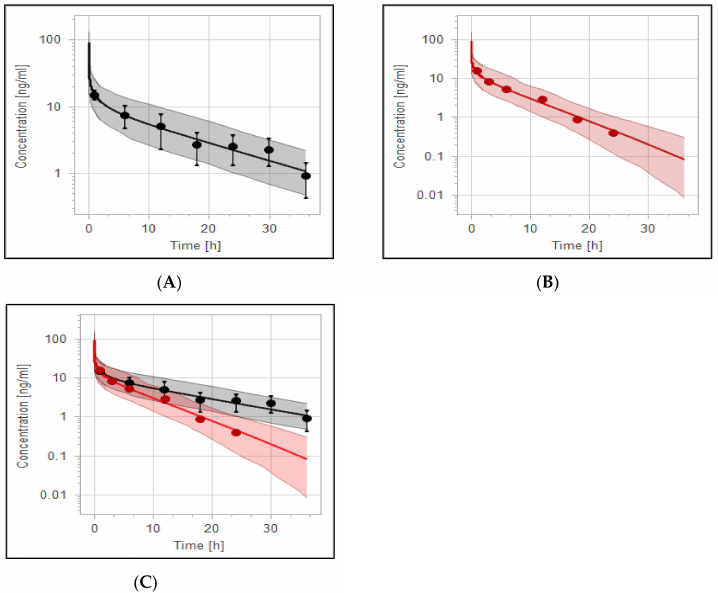
Figure 7. Effect of tuberculosis on PK of haloperidol with and without anti-TB rifampicin as a CYP3A4 inducer. ( A ) Haloperidol 5 mg IV in TB patients not treated with rifampicin. ( B ) Haloperidol 5 mg IV treated with rifampicin. ( C ) Simulation comparison for haloperidol with and without rifampicin. The red solid line represents the mean plasma concentration of haloperidol alone, while the black solid line represents the mean plasma concentration of haloperidol plus rifampicin. Colorful circles are observed data for haloperidol with (black) and without (red)